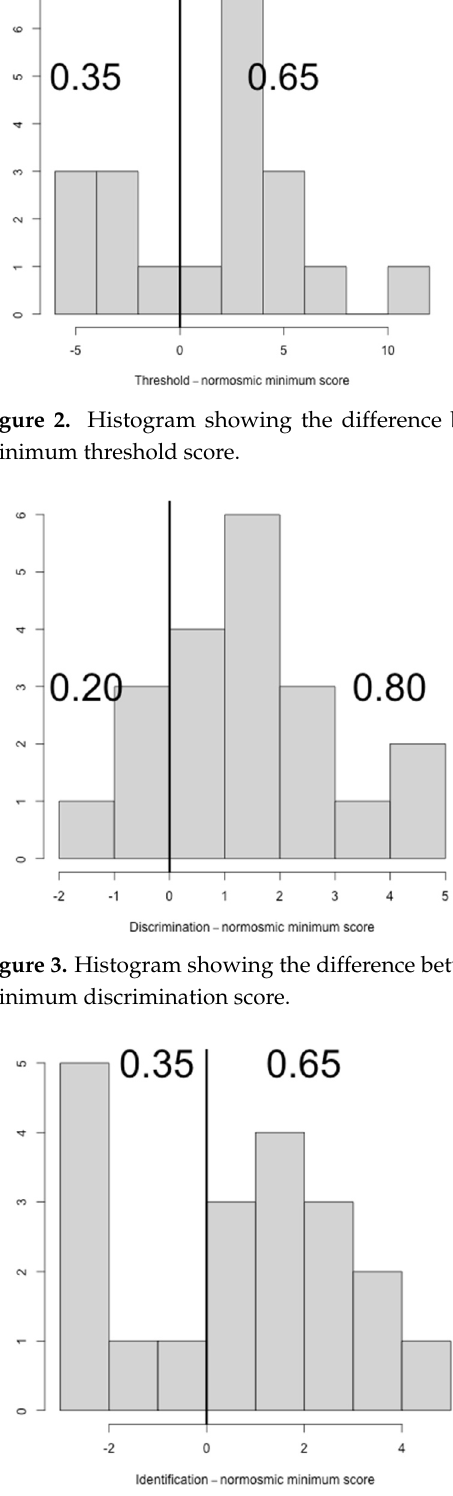
Figure 4. Histogram showing the difference between identification (I) scores and the normosmic minimum identification